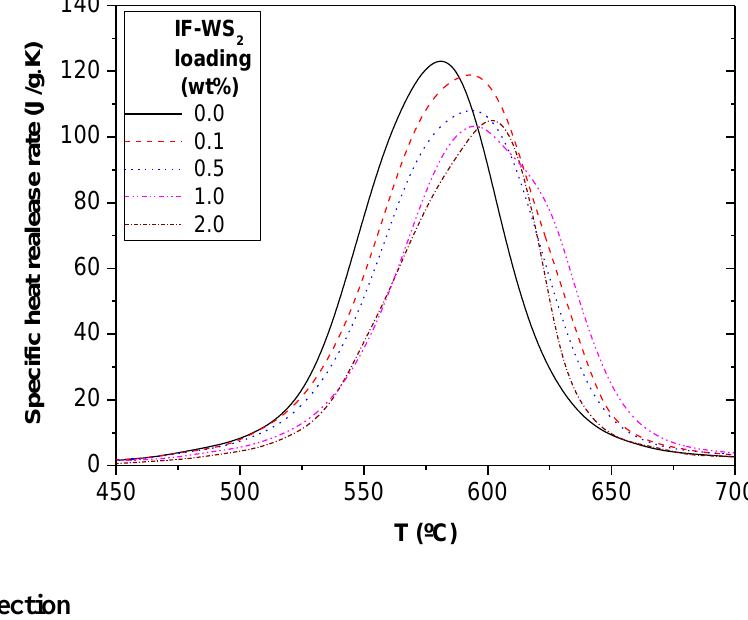
Figure 6. Heat release curves obtained from pyrolysis combustion flow calorimetry results for PPS/IF-WS /CF 2